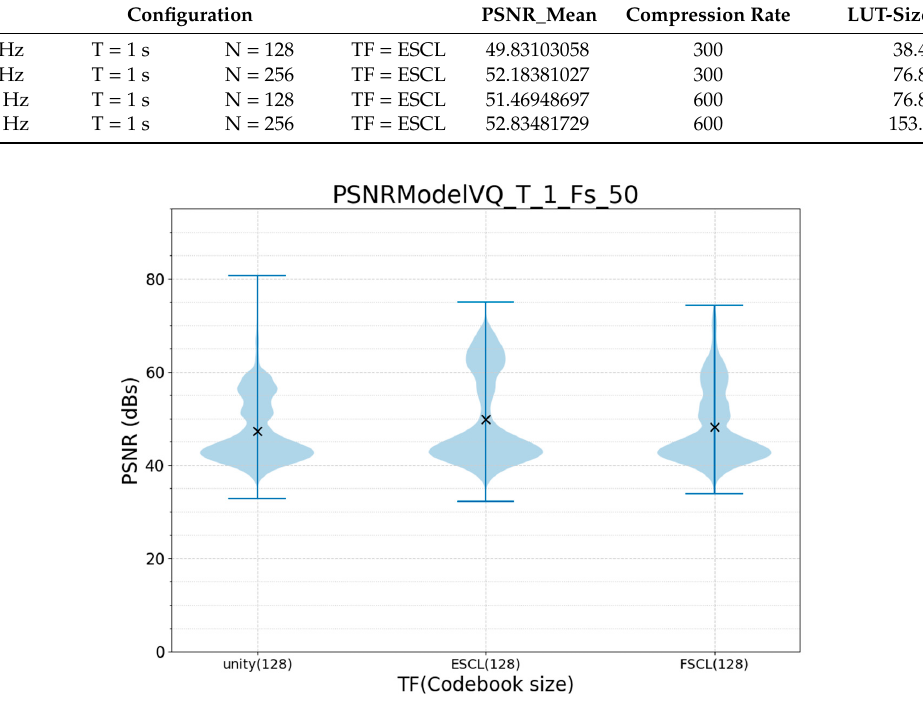
Figure 12. PSNR distribution and mean value (x) vs. the target function (F = 50 Hz, T = 1 s, N = 128).